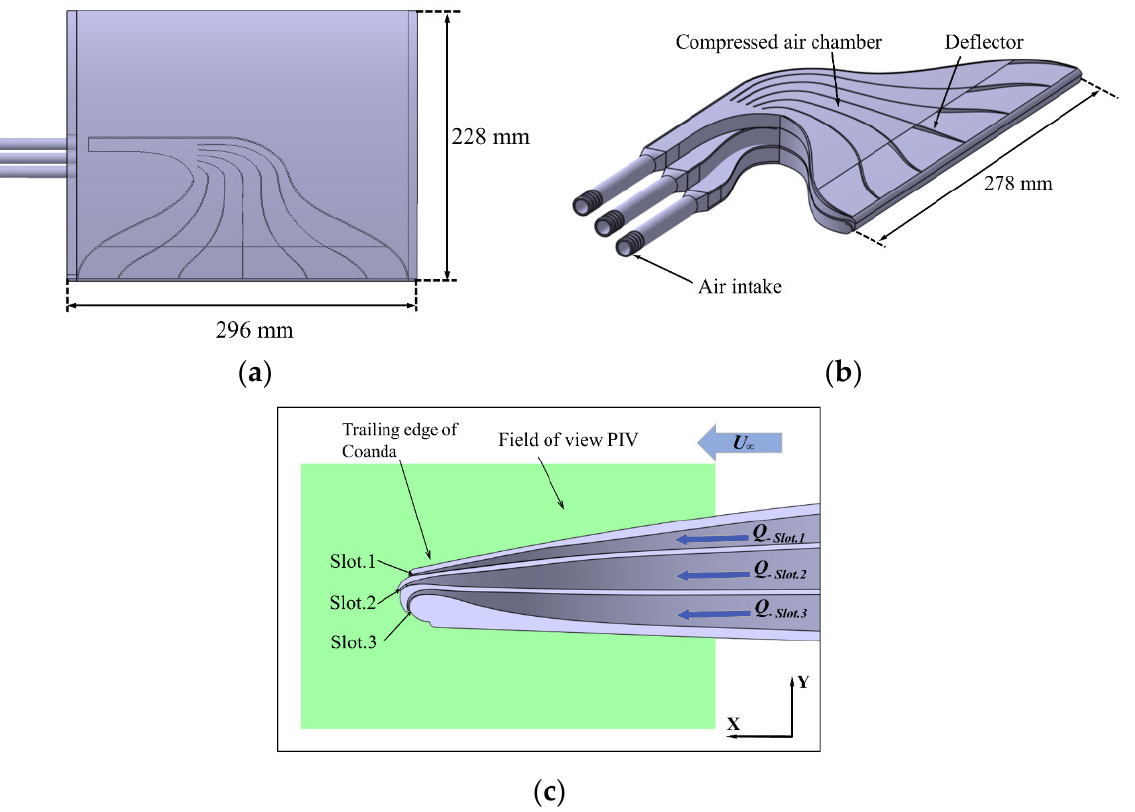
Figure 4. Multistage circulation control model. ( a ) Drawing of experimental model. ( b ) Multistage circulation control device. ( c ) Internal section view of wing trailing-edge and PIV shooting area.